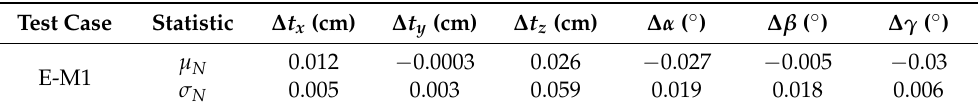
Table 20. Mean and standard deviation of the pose estimation errors in presence of uncertainties in the positioning of the markers on the target, for test case